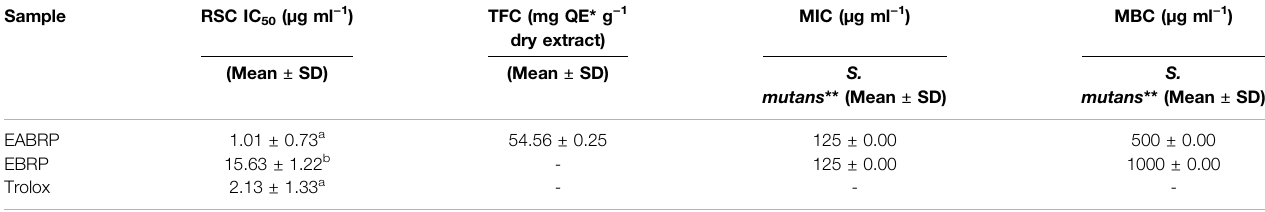
TABLE 4 | Radical scavenge capacity, total fl avonoids content, minimal inhibitory concentration and minimal bactericidal concentration of BRP extracts.